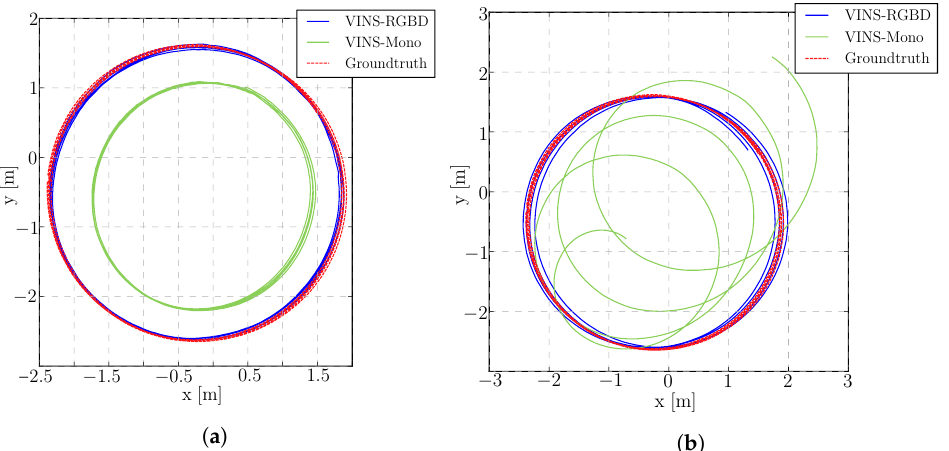
Figure 7. Scale drift evaluation with loop closure ( a ) and with deactivated loop closing ( b ). The trajectories are produced by a wheeled Jackal UGV.